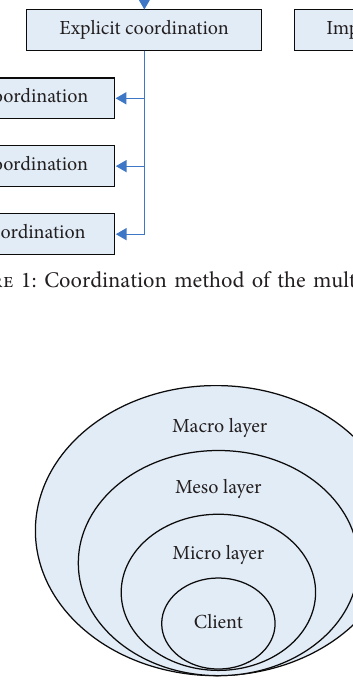
Figure 2: Framework structure of the inclusive financial